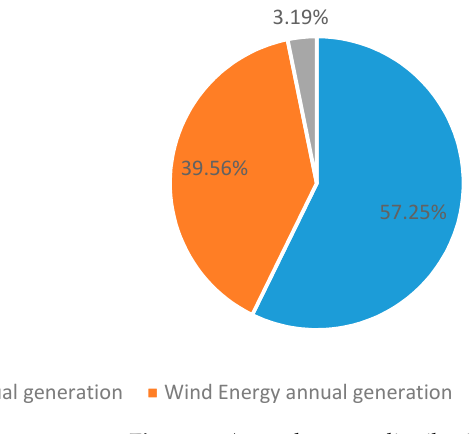
Figure 6. Annual energy distribution.